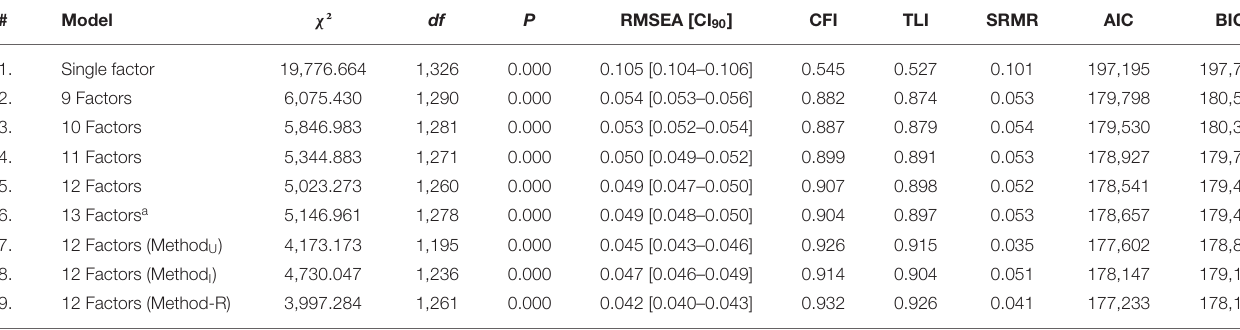
TABLE 1 | Fit statistics for different measurement